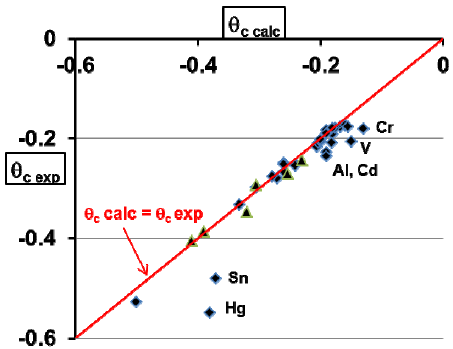
Figure 2. Experimental undercooling temperatures versus calculated undercooling temperatures. The experimental reduced crystallization temperatures θ plotted versus the calculated ones θ the atom number n , the smaller is the undercooling temperature, as shown in Table 1.